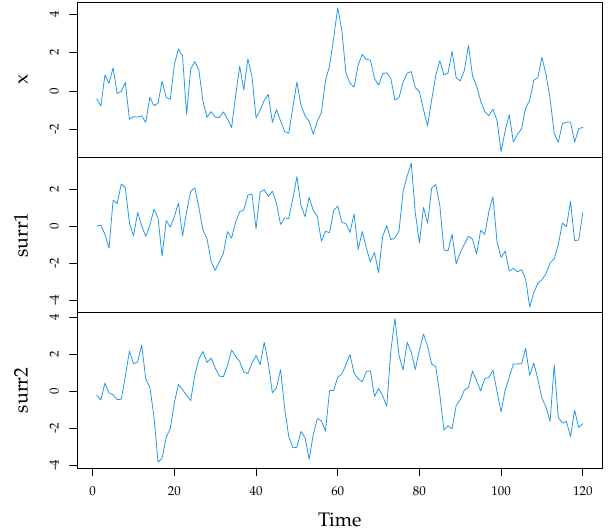
Figure 11. Time series from a AR(1) process together with two surrogate/resampled time series generated through the smoothed sieve bootstrap